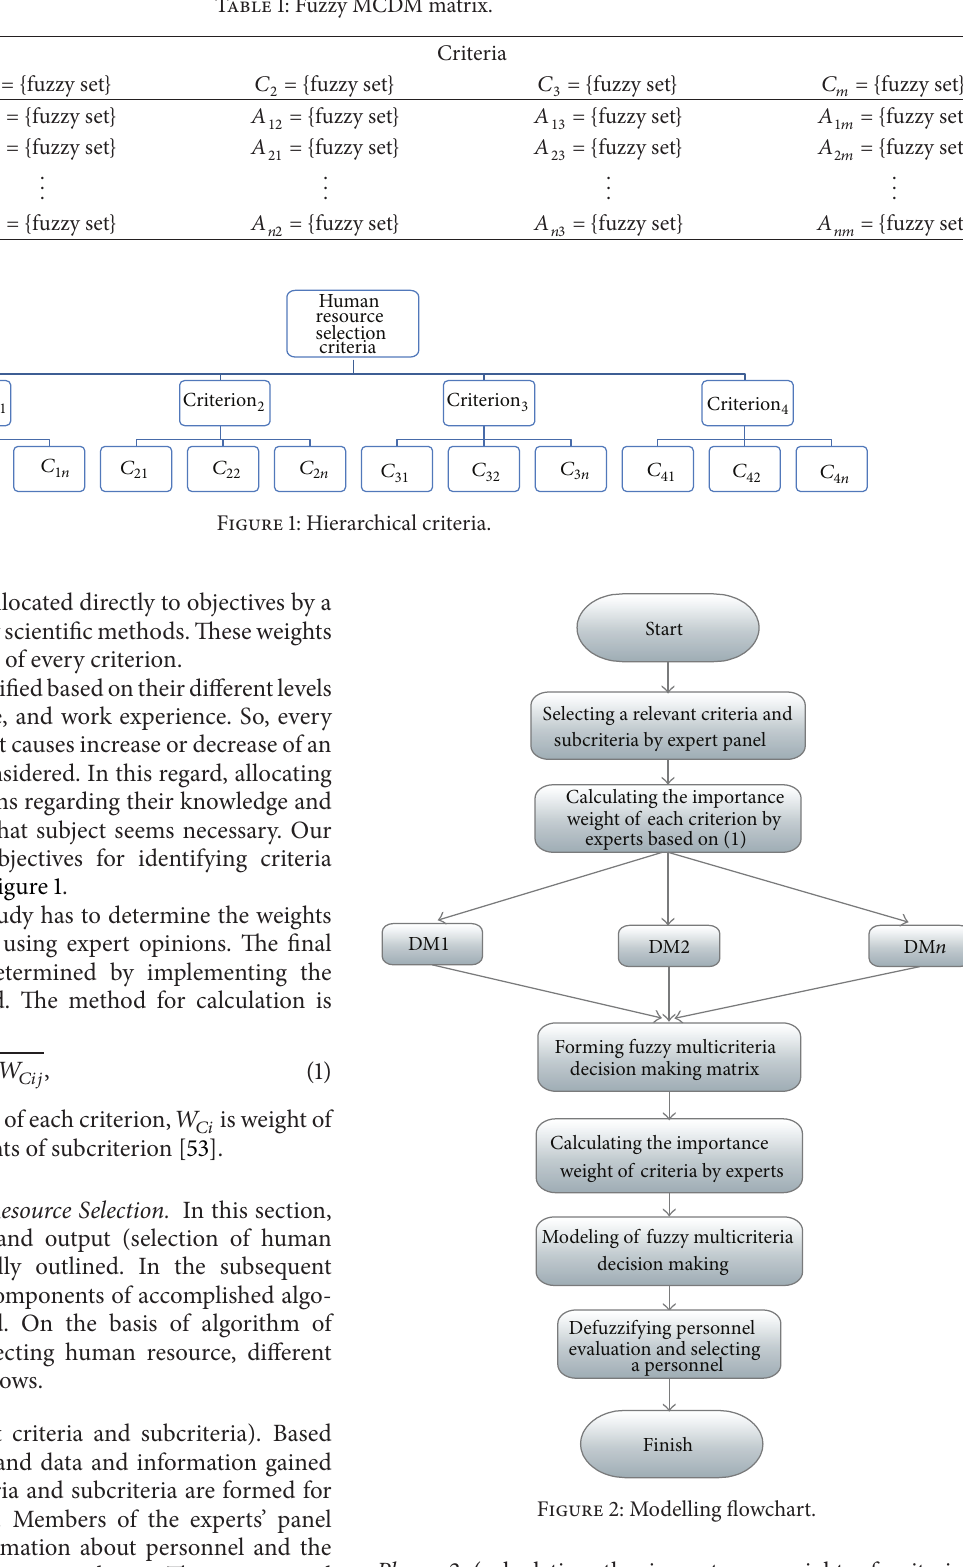
Table 1: Fuzzy MCDM matrix.